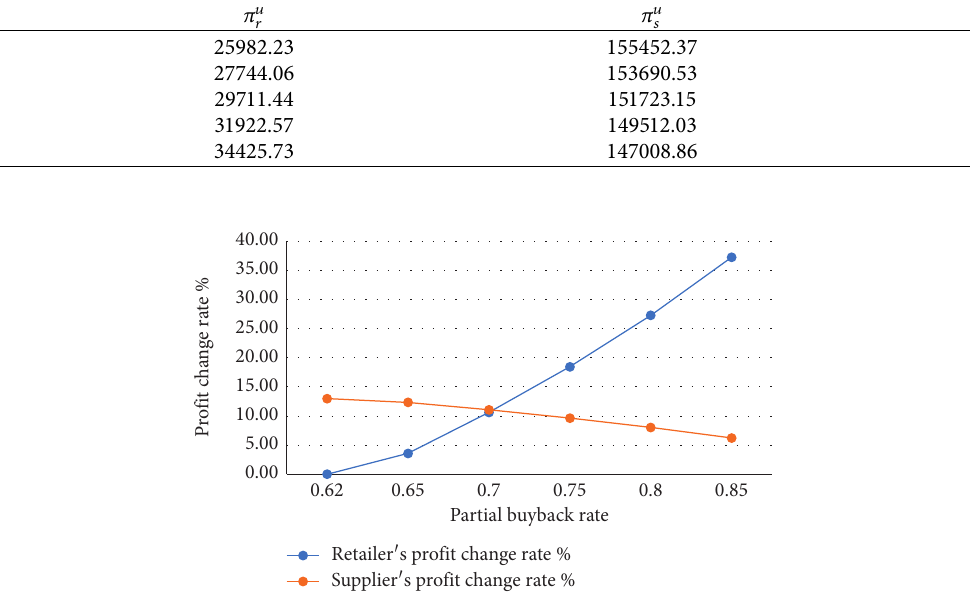
Figure 3: Sensitivity of partial buyback